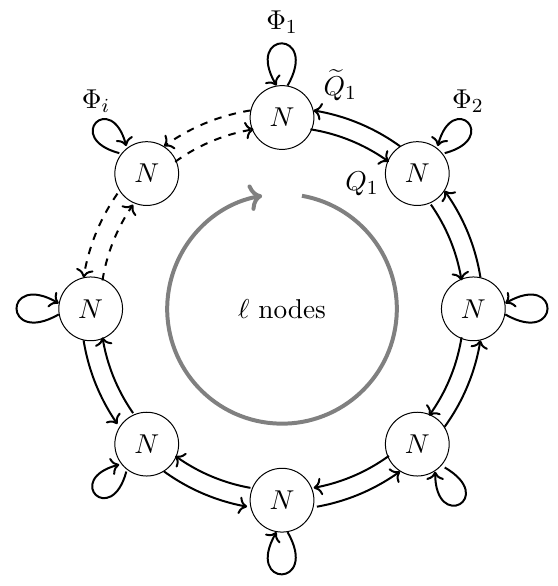
Figure 7. The circular quiver with gauge group U( N ) ‘